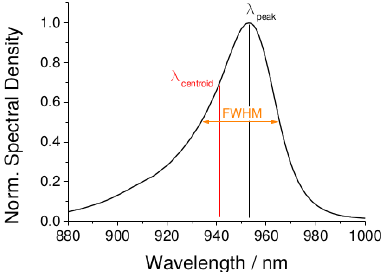
Figure 6. The real model of the distribution spectra of a 940 nm LED source is a skewed Gaussian (left or right leaning), modified from [46].